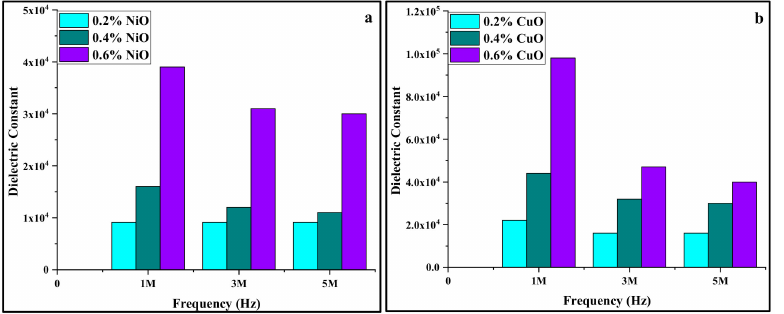
Figure 7. Bar graph showing trend of dielectric constant ( a ) wt% of NiO ( b ) wt% of CuO in PVA with variation in frequency.